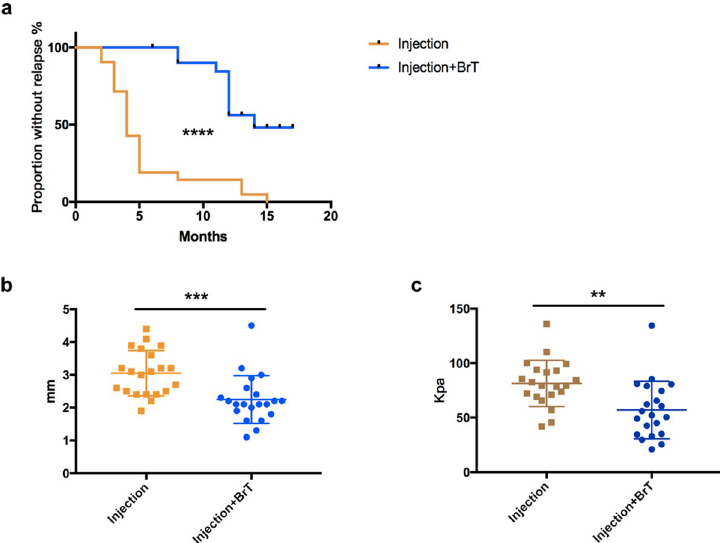
Fig 4. 90Sr prevent keloid from recurrence after injection treatment. (a) relapse analysis of experimental and control groups. (b) ultrasonic tissue thickness comparison between the two groups measured at 6-month post- brachytherapy or before (relapsed). (c) ultrasonic elastic modulus comparison between the two groups measured at 6-month post-brachytherapy or before (relapsed). �� p < 0.01; ��� p < 0.001; ���� p <